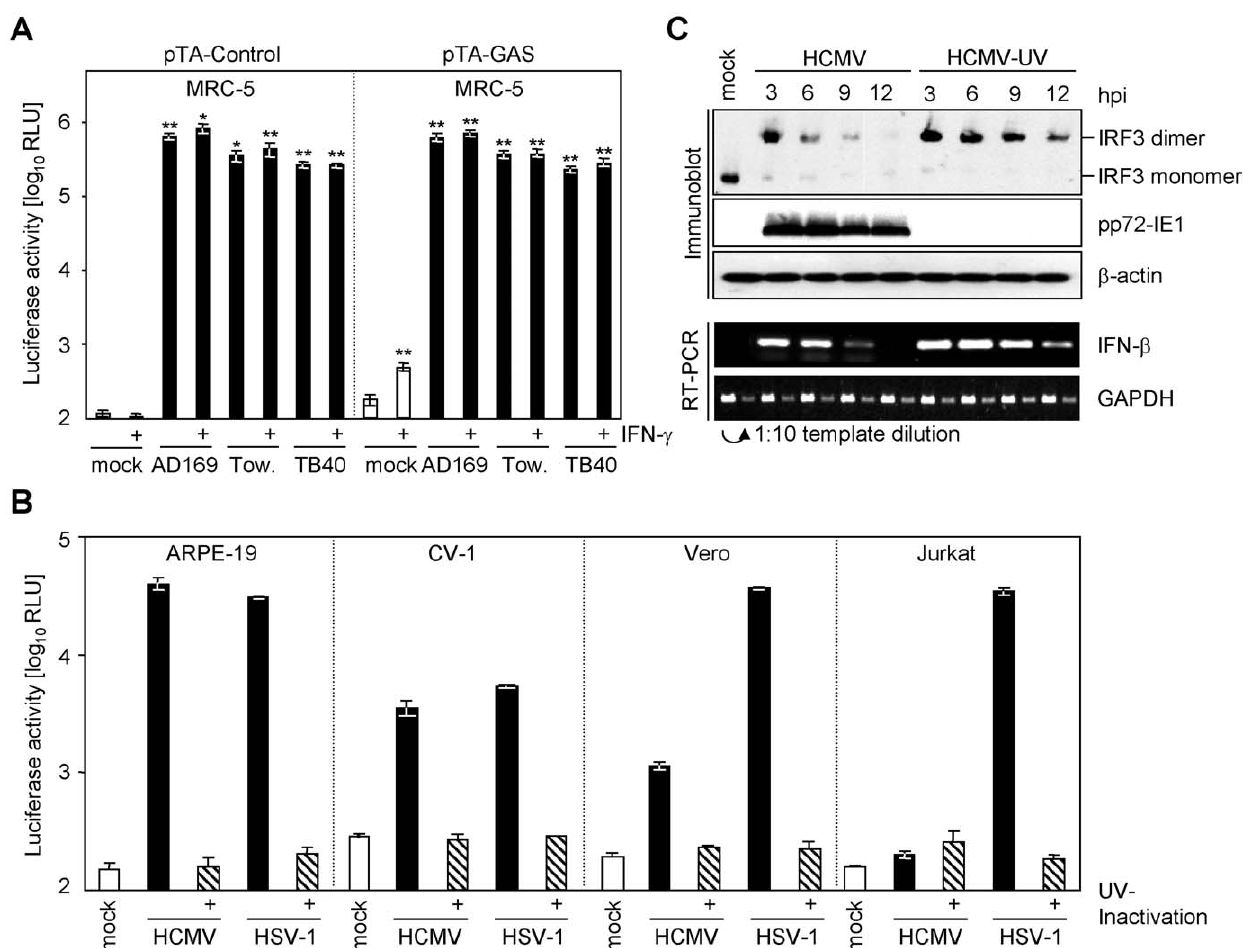
Figure 1. Herpesviruses transactivate the pTA-luc plasmid series. ( A ) Human MRC-5 cells, transiently transfected with the pTA-Control plasmid (left panel) or pTA-GAS (right panel), were split into aliquots and seeded. Cells were infected with 1 PFU/cell HCMV-AD169, HCMV-Towne, HCMV-TB40/E (black bars) or left uninfected (white bars). After 24 h the cells were treated for additional 5 h with 500 U/ml human IFN- c . Cells were lysed and luciferase activity was measured. The experiment was performed in triplicate and the arithmetic mean with the standard deviation is shown. The significance was tested with the Student’s t-test: * p , 0.05 and ** p , 0.01. ( B ) ARPE-19, CV-1, Vero and Jurkat cells were transfected with 2.5 m g pTA-Control plasmid using the Lonza nucleotransfection system. Cells were split so that parallel measurements and infections originated from the same transfection. 20 h post transfection cells were left uninfected (mock; open bars) infected with 3 PFU/cell HCMV-AD169, HSV-1 F strain (black bars) or UV-inactivated virus (hatched bar) for additional 20 h. Cells were lysed and luciferase activity was measured. ( C ) MRC-5 cells were infected with 3 PFU/cell HCMV-AD169 or UV-inactivated HCMV-AD169. After the indicated time cells were lysed and total RNA or protein was prepared. Protein lysates were subjected to native sodium-deoxycholate-PAGE for the analysis of IRF-3 dimerization or to SDS-PAGE for the analysis of pp72-IE1 and b -actin protein amount. Proteins were transferred to filters and probed with the indicated antibodies. IFN- b and GAPDH mRNA was assessed by semi-quantitative RT-PCR from total RNA as. For GAPDH two log 10 dilutions were used as template to confirm measurement in the